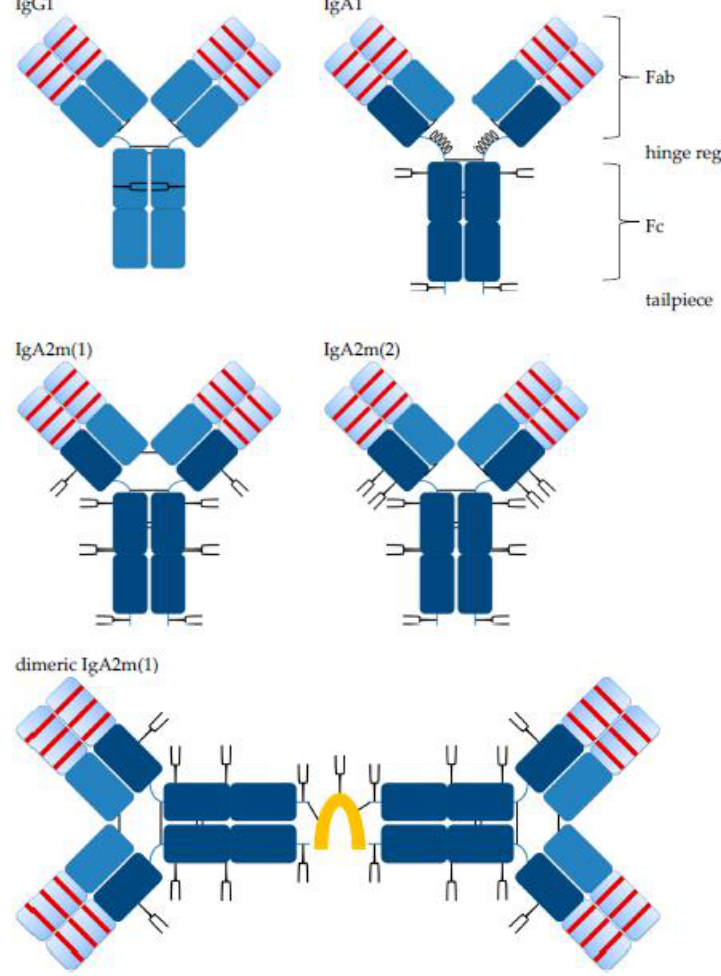
Figure 1. Schematic illustration of IgG1 and IgA antibodies. IgG Cγ and common Cκ light chain domains (both blue) and IgA Cα domains (dark blue) are indicated. Variable domains (light blue) including complementary-determining regions (CDRs, red bars) of heavy and light chains are indicated. N -glycosylation sites ( Y ) with their different orientation towards the inside or outside of the molecules are indicated for IgG or IgA, respectively. Antibodies might possess N -glycosylation sites within their variable domain, which is not shown here. The tailpiece for IgA antibodies is shown, which is not present for IgG antibodies. Inter-chain disulfide bonds (black lines) of heavy and light chains are indicated and differ between isotypes and allotypes. In contrast to IgA2, in the extended hinge region of IgA1, O- glycosylation sites (0) are present. IgA2m(1) forms disulfide bonds between the two light chains. Dimeric IgA2m(1) include inter-chain disulfide bonds between the J chain (orange) and two IgA monomer units. The J chain stabilizes IgA dimers, but other interactions between IgA monomer units can result in the formation of dimers lacking the J chain. Adopted from Woof and Burton [18].